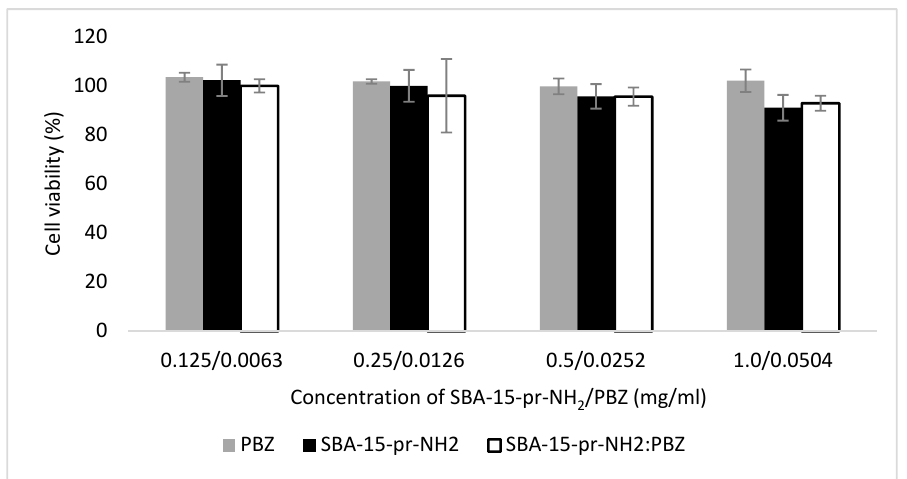
Figure 10. Caco-2 cell viability results after 2 h incubation with SBA-15-pr-NH 2 , SBA-15-pr-NH 2 :PBZ, and PBZ at 37 °C.